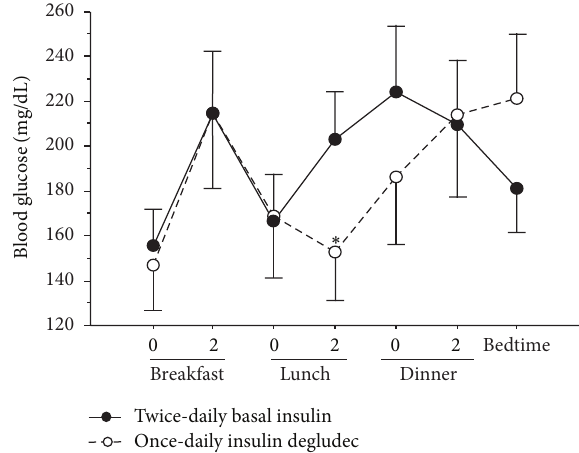
Figure 2: Average daily profile of blood glucose in patients treated with twice-daily basal insulin and once-daily insulin degludec. 0 and 2: blood glucose level before and 2 hours after the indicated meal. Blood glucose levels at 2 hours after lunch were significantly lower after switching than before switching. ∗ 𝑃 < 0.01 versus twice-daily basal insulin.